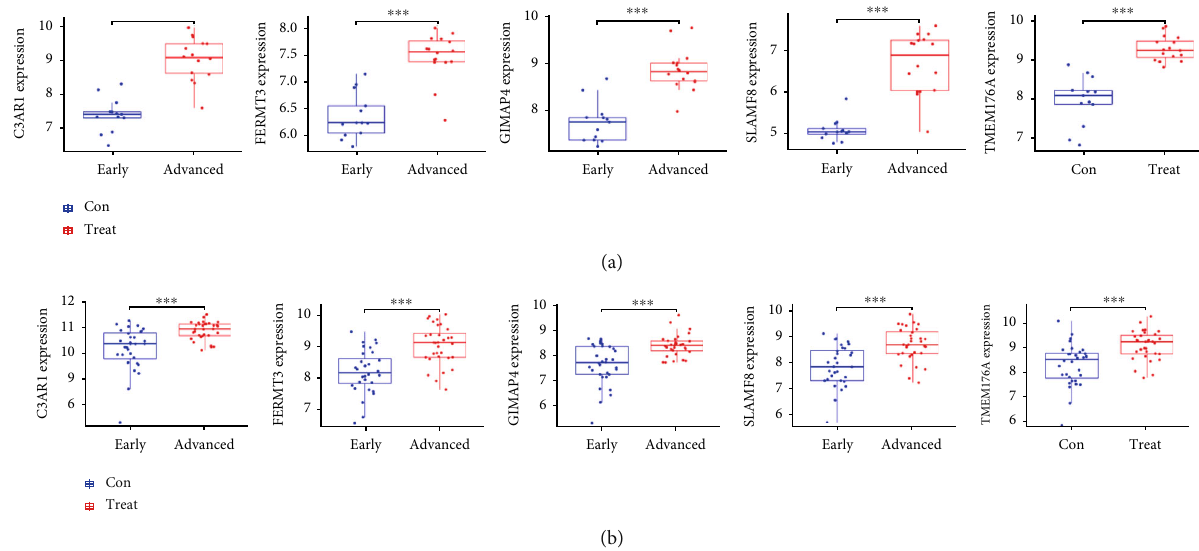
Figure 6: Validation of the expression levels of the identi fi ed hub genes. (a) Validating the hub gene expression in the GSE28829 dataset. C3AR1, FERMT3, GIMAP4, SLAMF8, and TMEM176A expression levels were remarkably elevated in the advanced carotid atherosclerotic plaques in relation to the early carotid atherosclerotic plaques. (b) Validating the expression of hub genes in the GSE43292 dataset. Similar fi ndings were noted as those in the GSE28829 dataset.